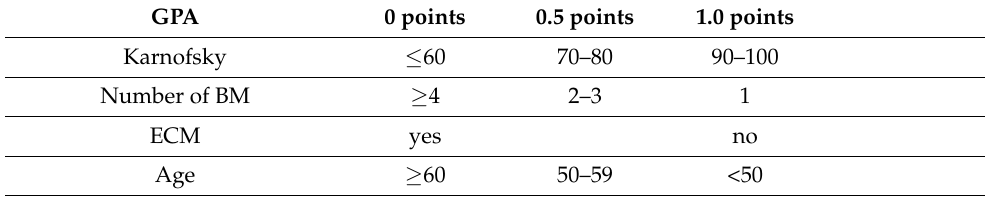
Table 1. Calculation of original graded-prognostic-assessment (GPA), Breast-GPA and updated